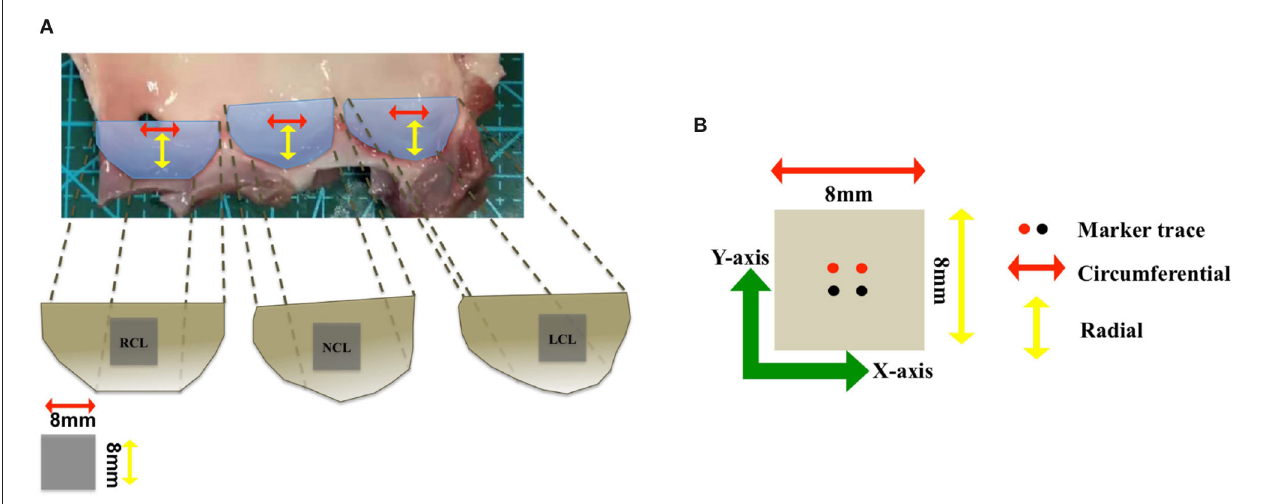
FIGURE 3 | (A) The geometry of the aortic valve (AV) consists of three leaflets: right coronary leaflet (RCL), non-coronary leaflet (NCL), and left coronary leaflet (LCL). (B) The vector illustration shows the circumferential direction (red arrow) and radial direction (yellow arrow), and two different colors of the markers trace are used to mark the sample in two directions (X-axis) and